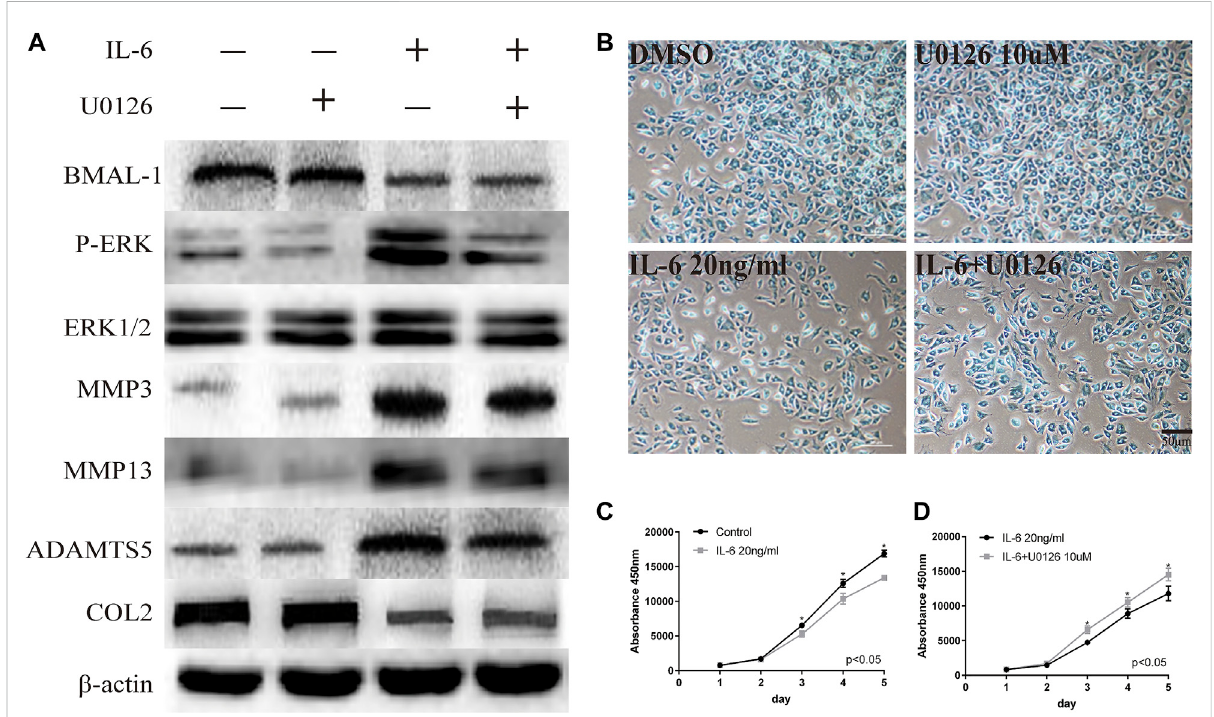
FIGURE 4 Regulatory relationship between BMAL-1/P-ERK and IL-6. (A) Western blot assays demonstrate the relationship between BMAL-1, P-ERK, MMP3, MMP9, MMP13, and COL2, while the expression levels of ERK1/2 and β -actin werethe same in thecartilagetissues of thecontrol group, CRD group and REC group. (B) Alcian blue staining results for MCCs stimulated with 20 nM or 10 μ M U0126 and 20 ng/ml IL-6 for 12 h. (C,D) A CCK-8 assay was used to examine the cell proliferation of each group and the effects of U0126; the absorbance was measured at 450 nm. All experiments were performed in triplicate, and the results are expressed as the mean ± SD. The p value is written in the fi gure corner. Scale bar: 50 mm. * p <